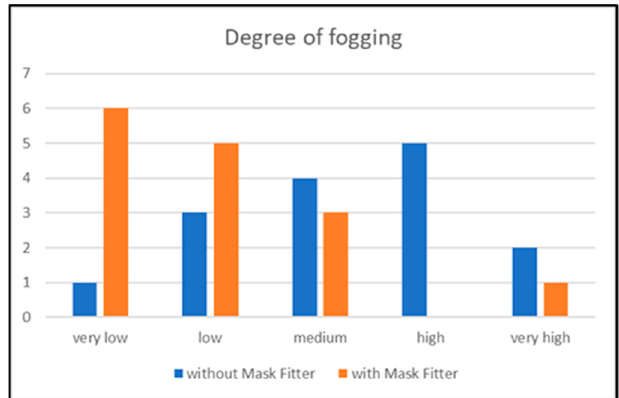
Figure 11. Effects of Mask Fitter on fogging of loupes and glasses.